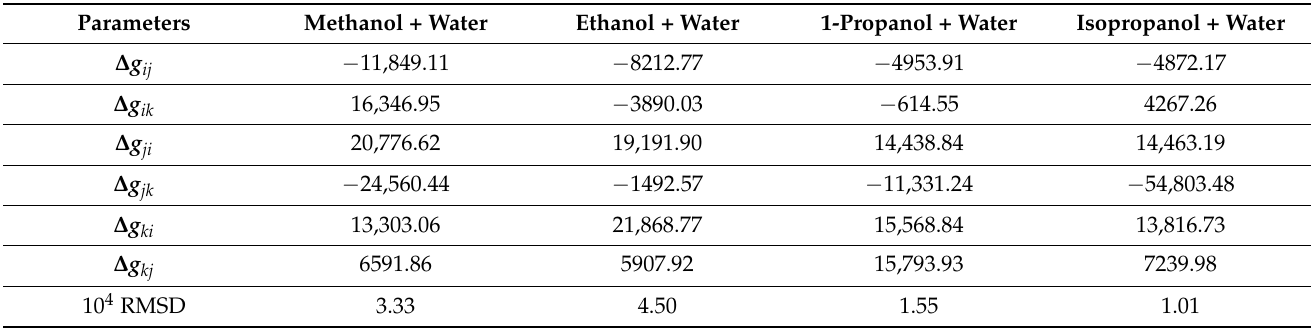
Table 8. Model parameters of NRTL model for molar ratio solubility of florfenicol in binary